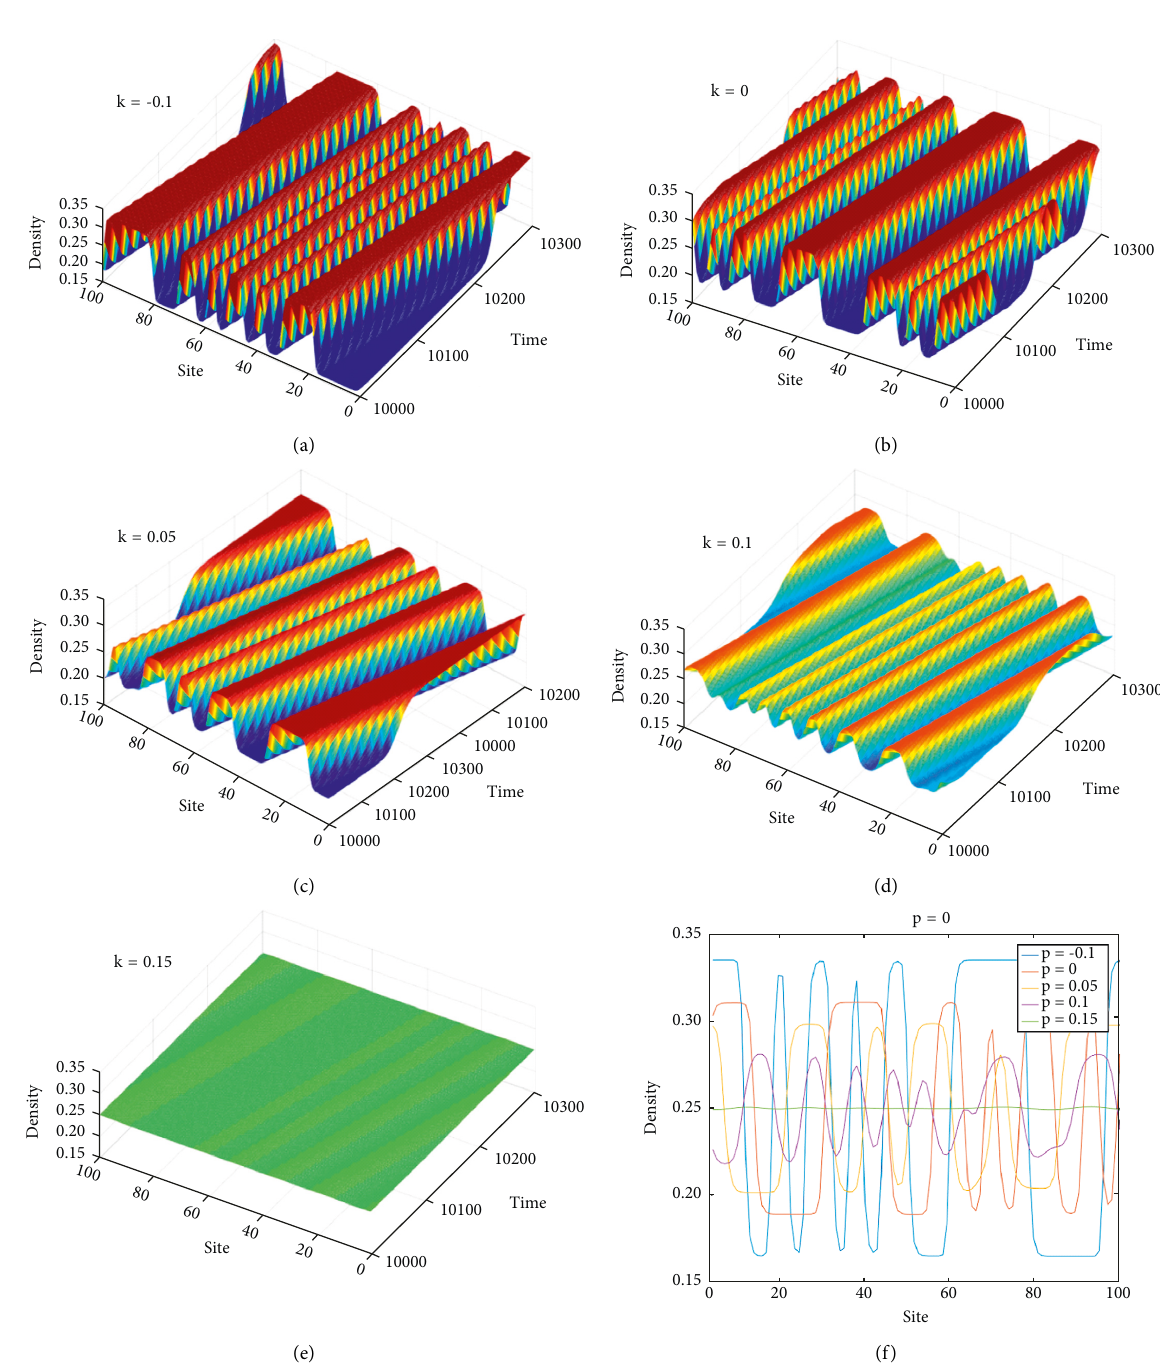
Figure 3: Spatiotemporal evolution of the density wave and cross-section view of the density wave with time under the action of different k . (a) k � 0.1. (b) k � 0. (c) k � 0.05. (d) k � 0.1. (e) k � 0.15. (f) p �